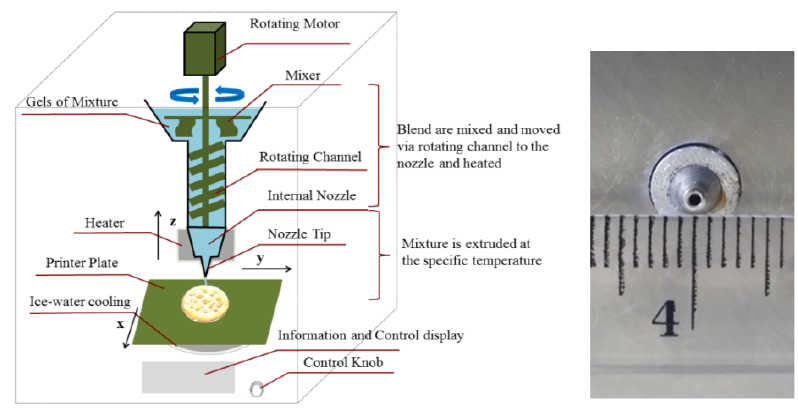
Figure 1. Schematic and nozzle size of the PORIMY 3D printer. The outline dimension is 380 × 390 × 610 mm (width × length × height).